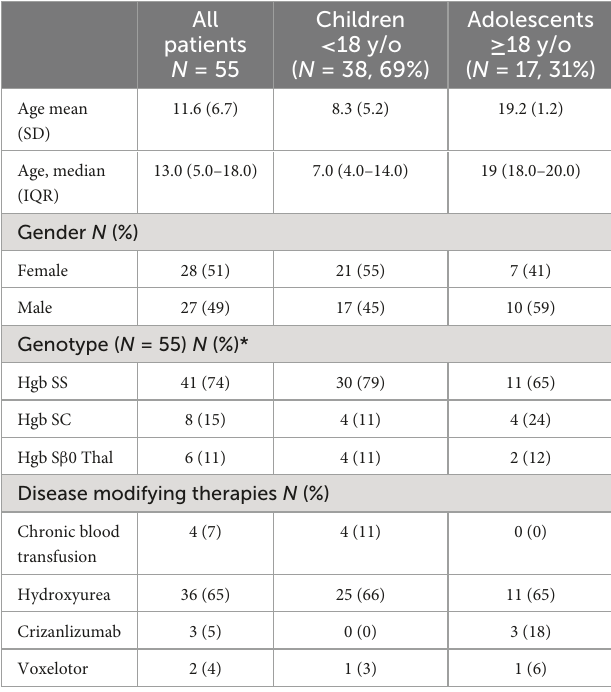
TABLE 1 Demographics and baseline characteristics.